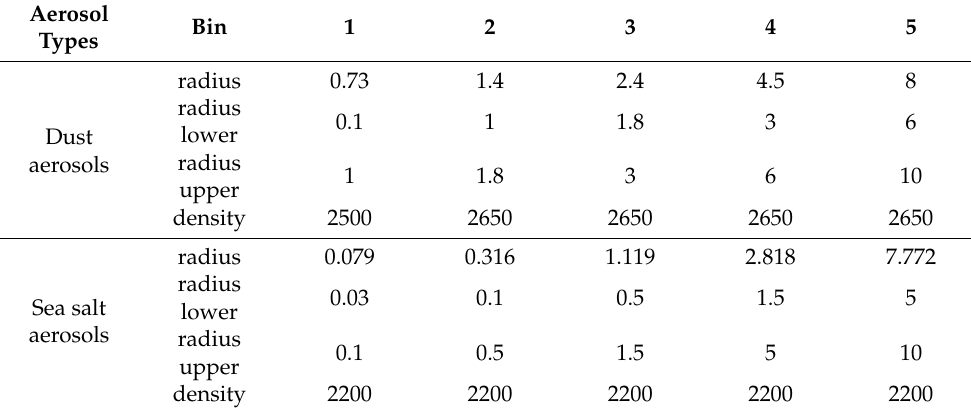
Table 3. The bin sizes information for dust and sea salt